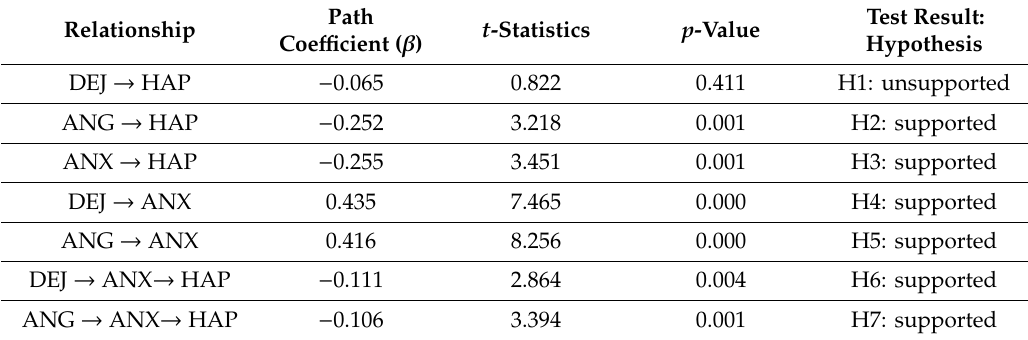
Table 7. Hypothesis testing